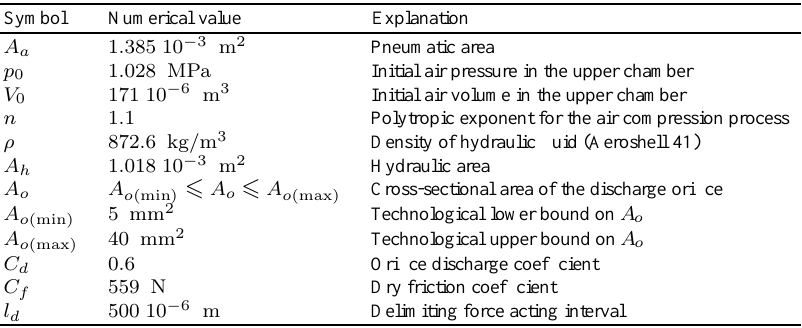
Table 1 Symbols used in Eq. (4) to Eq. (7)